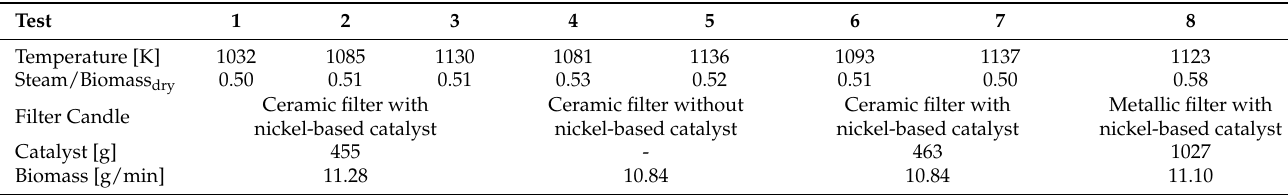
Table 3. Process conditions of the gasification